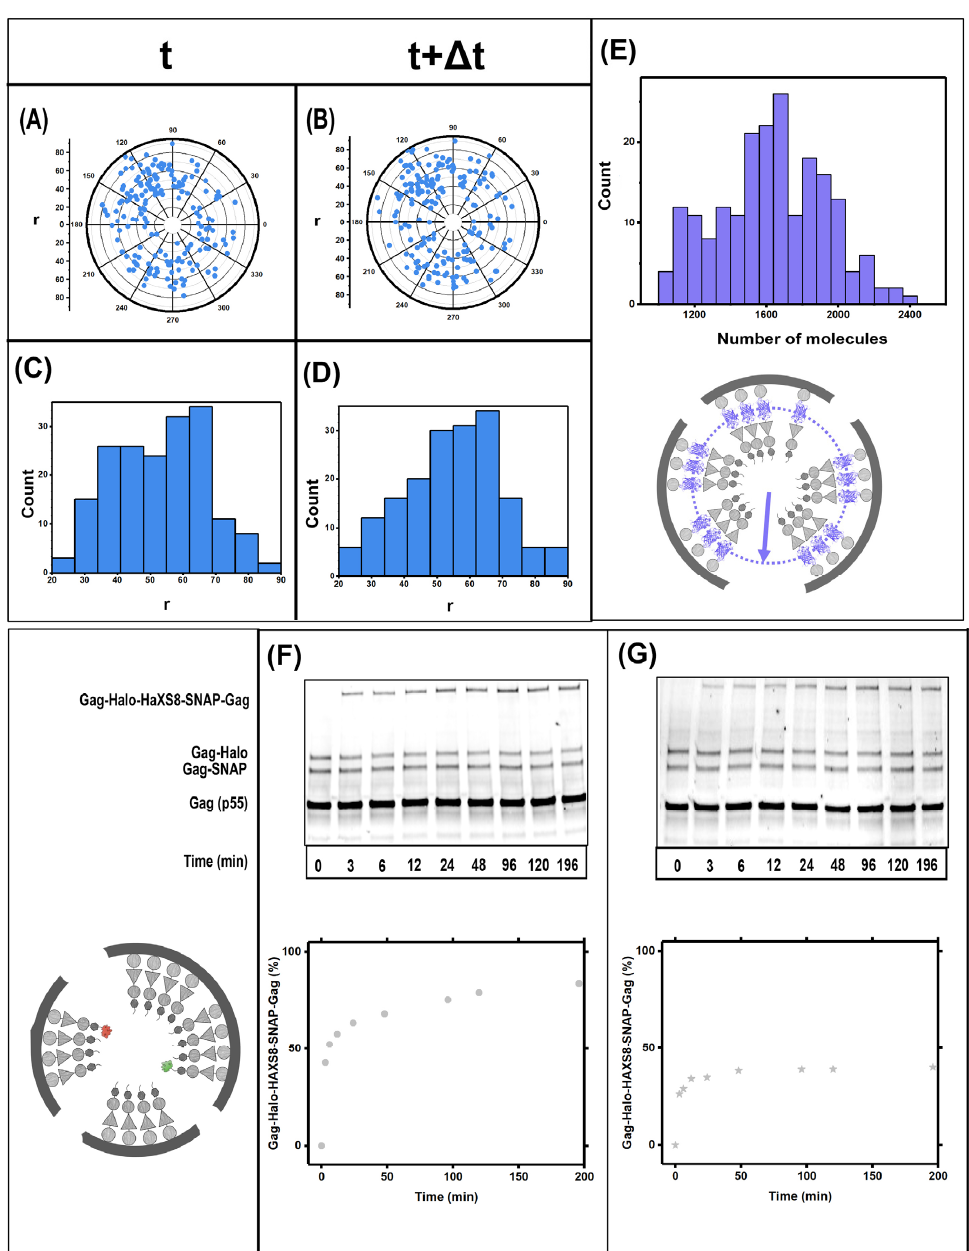
Figure 5. Effects of melittin on Gag dynamics within VLPs. ( A – E ) shows the measurements of dynamics in Gag(MA-Dendra2-CA)VLPs utilizing iPALM as previously shown in Figure 1. As shown in ( C , D ) We detect a slight decrease in the radius of the Dendra2 localization within the VLPs punctuated by melittin when compared to the VLPs shown in Figure 1. The number of Gag molecules within 200 representative VLPs is shown in € and the histogram is similar to the histogram of number of Gag molecule s presented in Figure 1. Therefore addition of melittin did not result in loss of Gag molecules from the VLPs. There is no dynamic detected within the VLP as shown in A and B in the presence of melittin. ( F , G ) show the rate of formation of Gag-Snap-Gag-Halo hetero dimer in the presence of HaXS8 and different concentration of melittin ( F ) 0.1 µ M and ( G ) 0.2 µ